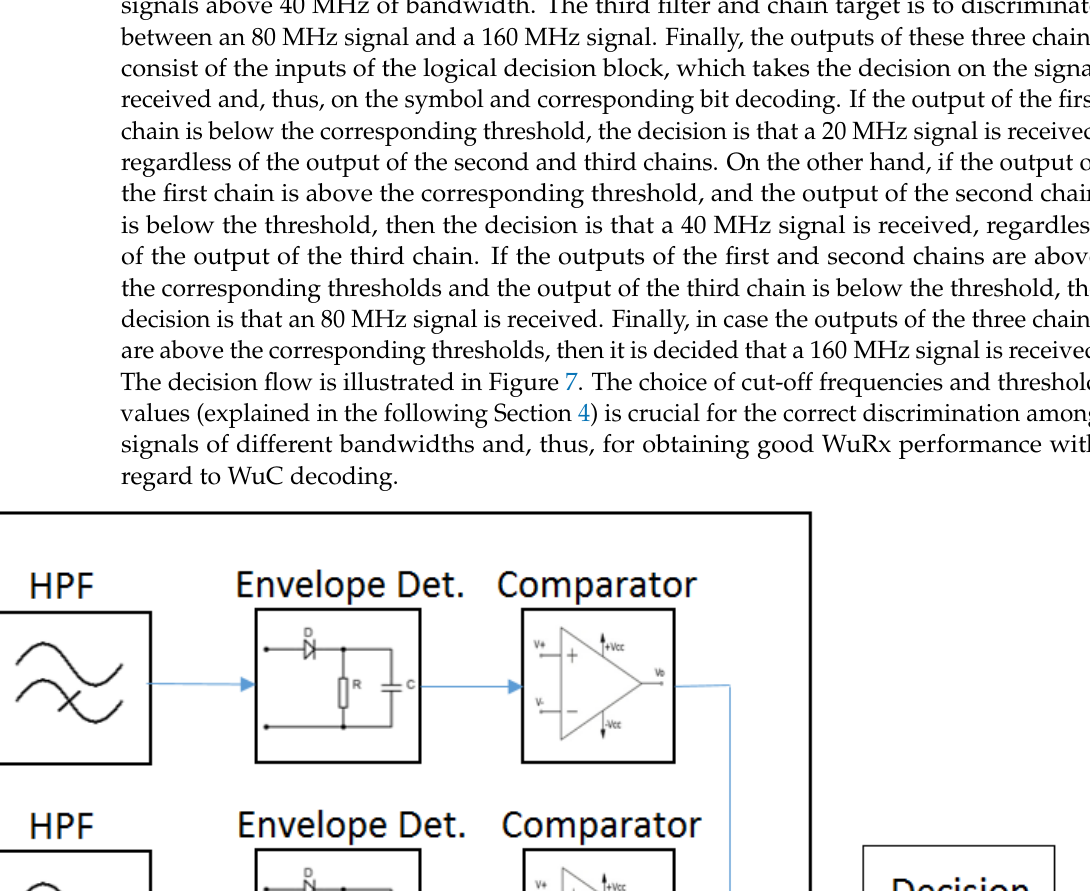
Figure 5. Main composition of WuRx.